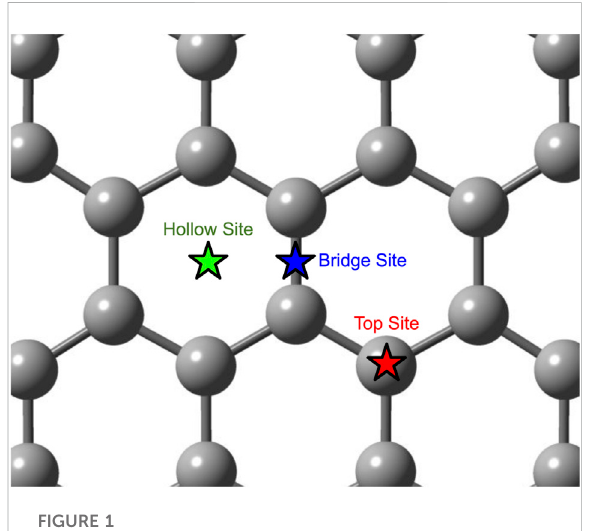
FIGURE 1 Diagram of the three possible adatom binding sites on a graphene